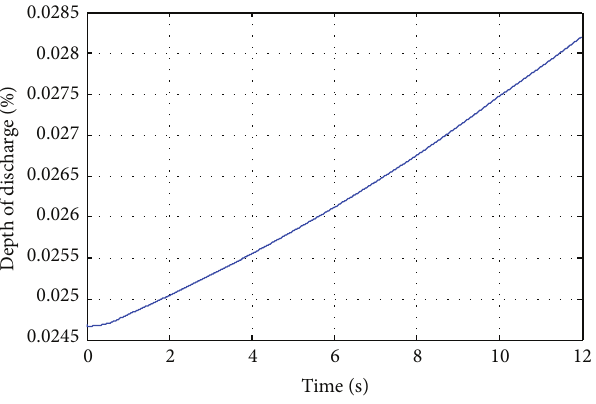
Figure 13: Evolution of the DOD in the different